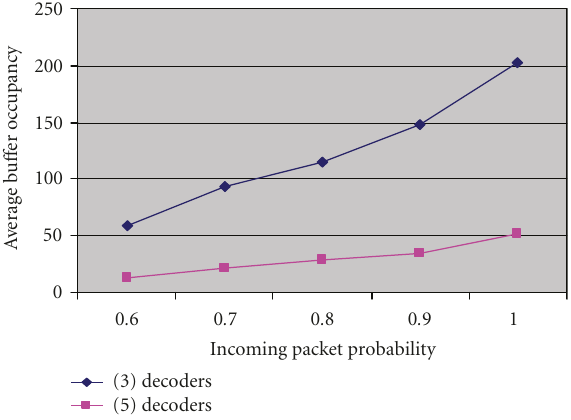
Figure 16: Blocking probability versus incoming packet probability ( T = 10,100).